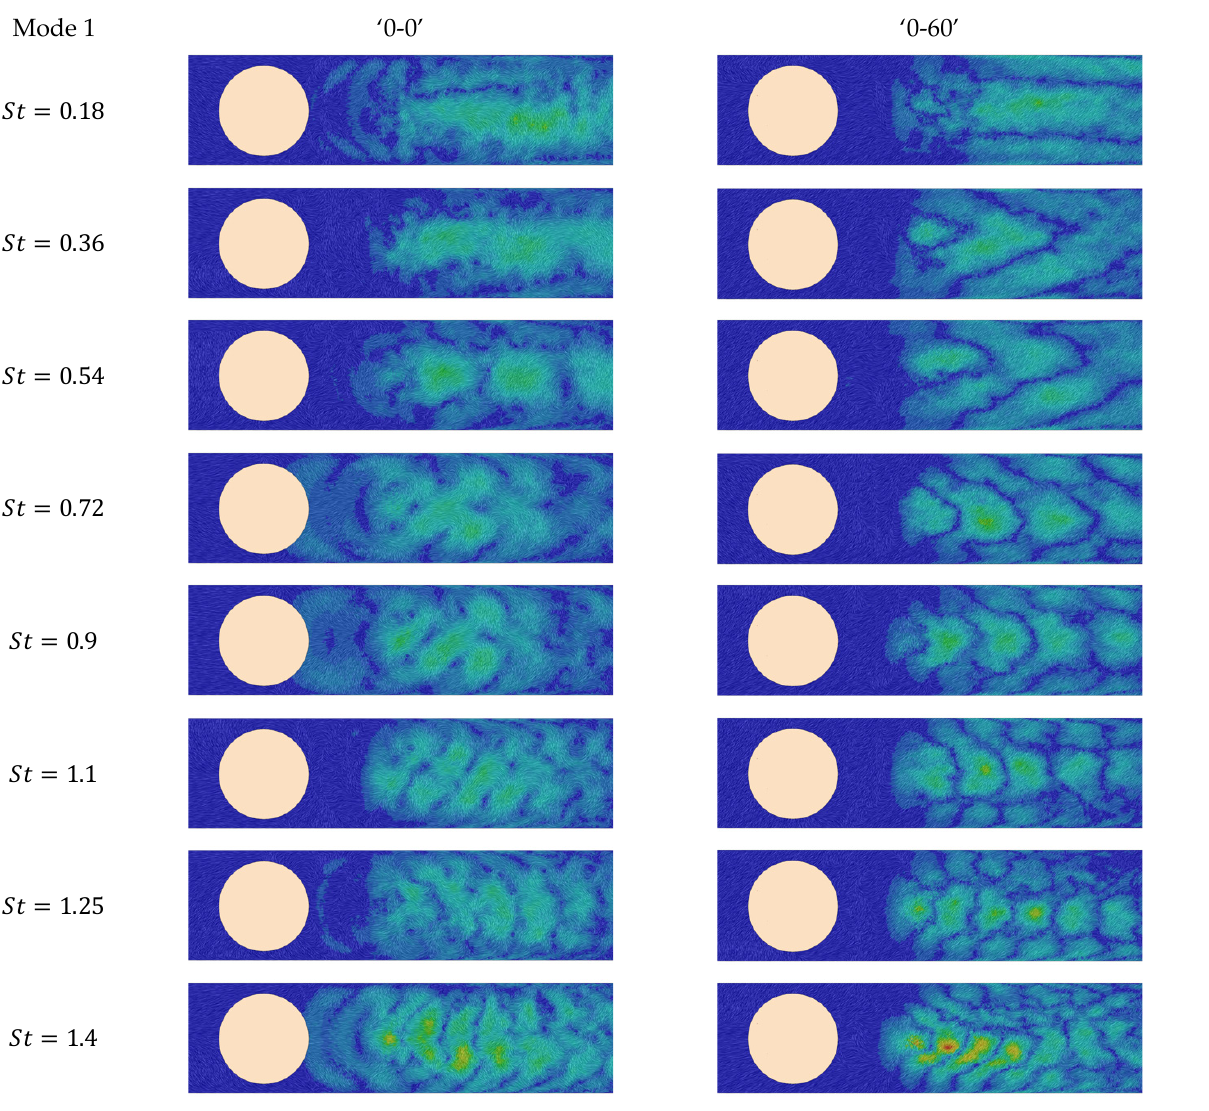
Figure 25. Contours plots of mode 1 of in-plane velocity vector coloured by mode magnitude for XY plane.